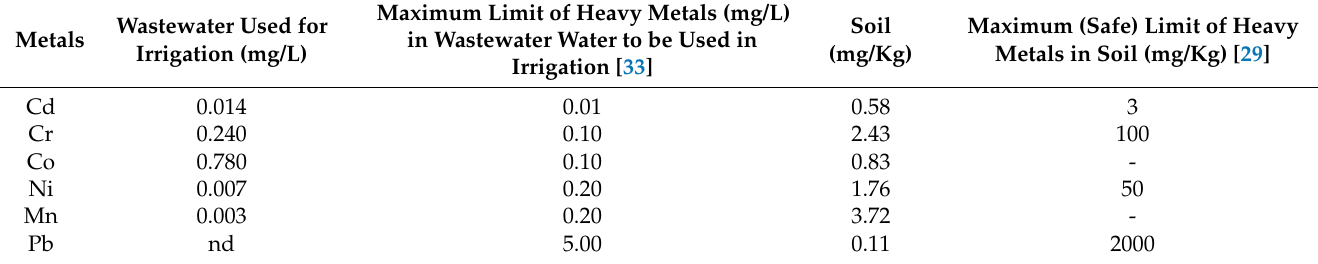
Table 1. Concentrations of heavy metals in wastewater used for irrigation and in irrigated soil. The maximum limits of metals in soil and wastewater regarded as safe have been